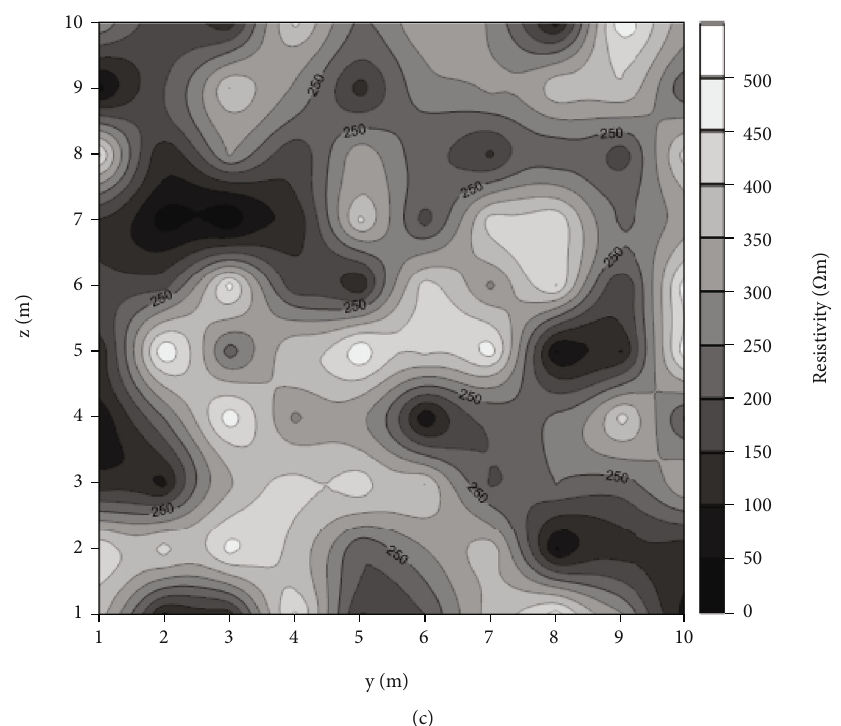
Figure 10: Distribution of randomly generated resistivity: (a) x - y plane; (b) x - z plane; (c) y - z plane.